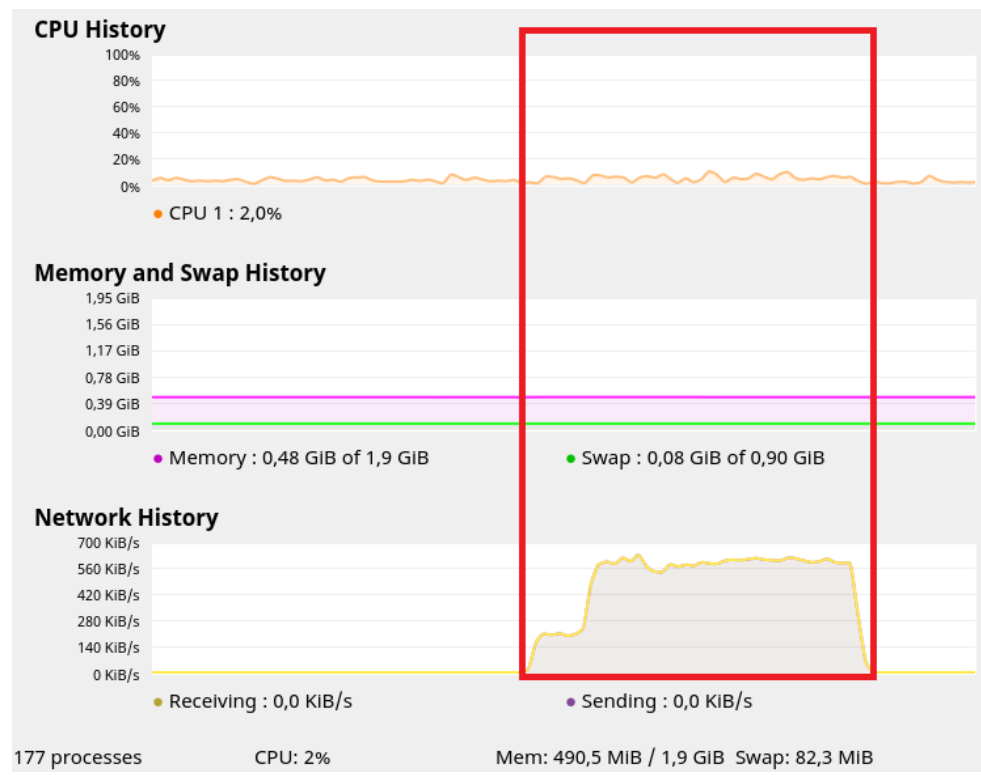
Figure 9. System load of the monitoring device attack period in the red